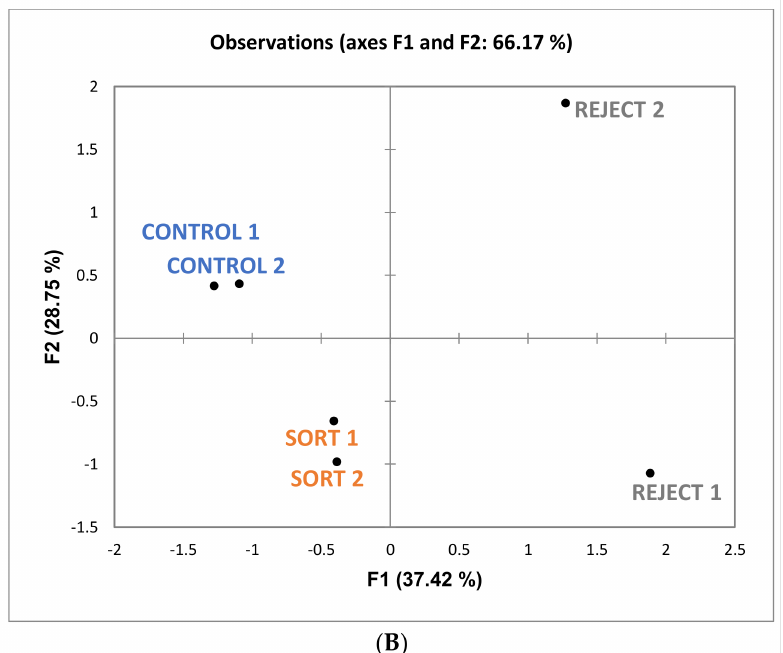
Figure 7. Loadings ( A ) and score ( B ) plots of a multiple factor analysis (MFA) between volatile compounds (blue) in Grenache wines that differed significantly, and all sensory attributes (red) generated from the respective descriptive analysis panel. Only biological replications consistent with those for sensory were included in the